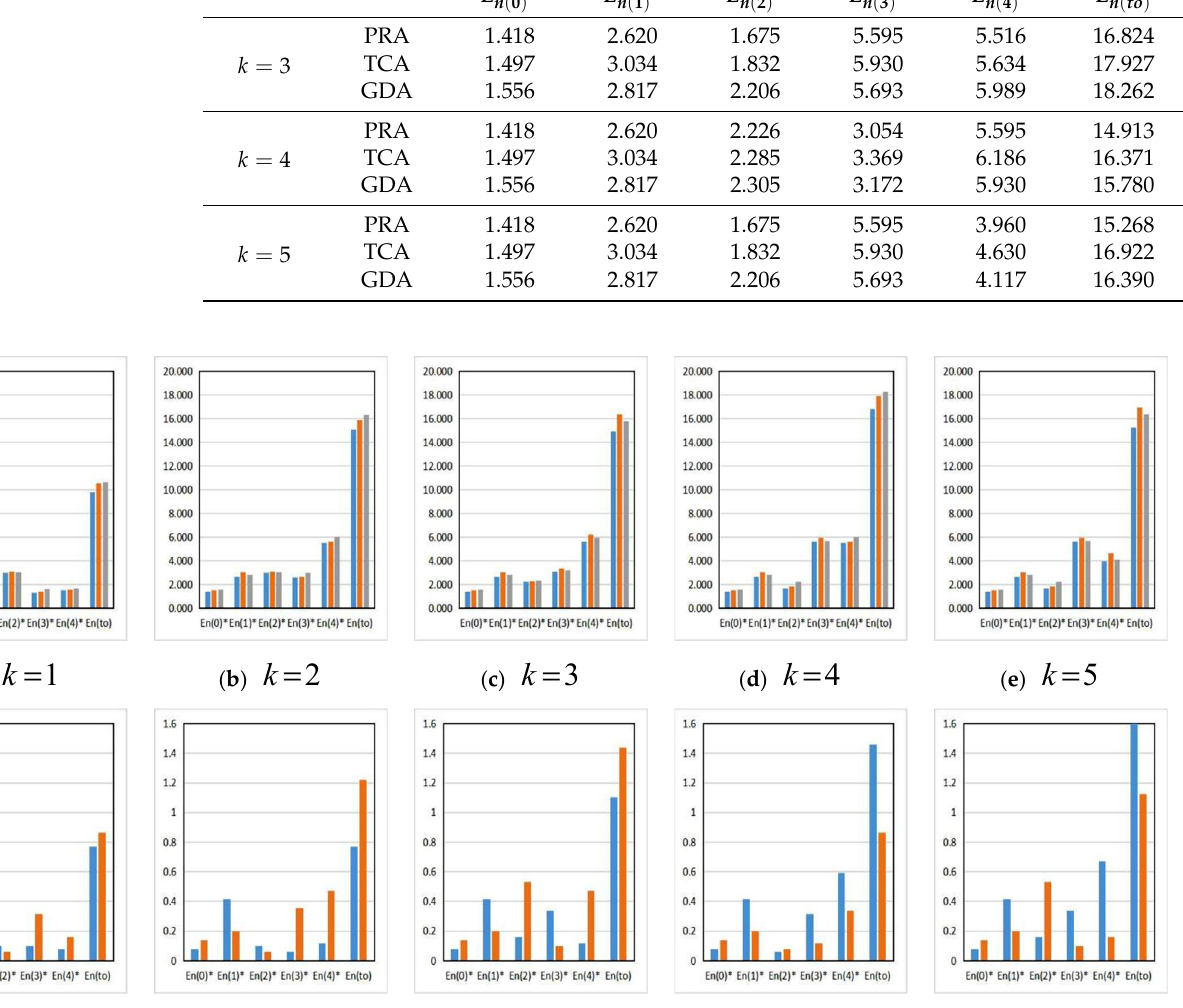
24 of 30 Table 6. Comparison of the emission volume of the three algorithms under the different cluster conditions (unit: kg). stands for the optimal emission volume in each road interval.